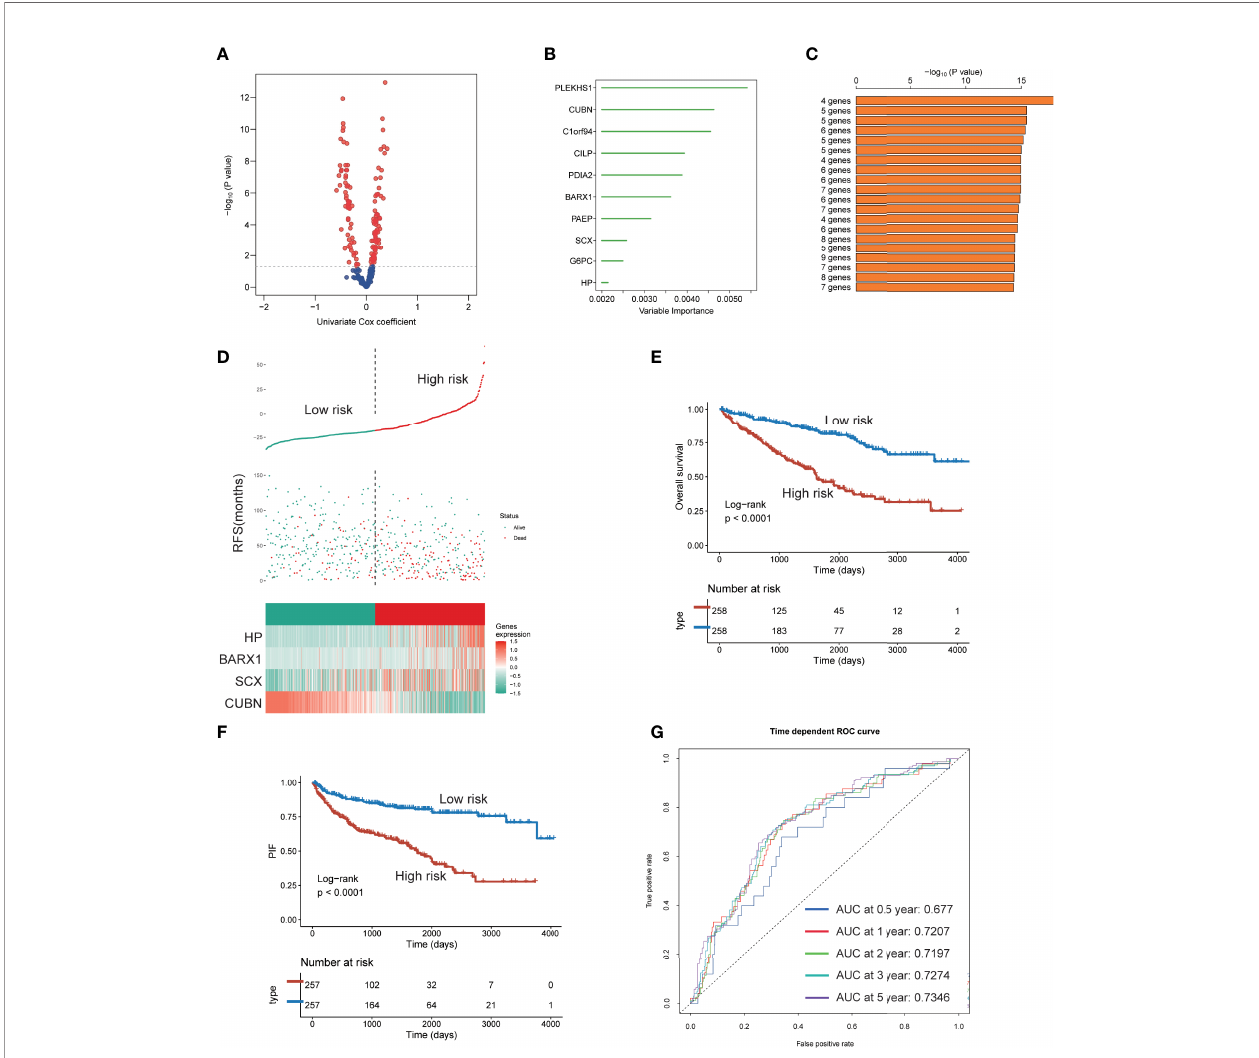
FIGURE 10 | Establishment of a four IGF genes risk model. (A) Volcano plot indicating the signi fi cantly altered biomarkers among the three subtypes by univariable Cox regression analysis. (B) Random survival forest analysis screening 10 genes. (C) Based on various combination analyses, the top 20 signatures are listed according to p-values. (D) Risk score analysis in TCGA-ccRCC cohort. (E-F) Survival analysis for OS (E) and PFS (F) of the two risk groups in TCGA-ccRCC cohort. (G) The time-dependent ROC curves for the two risk groups in TCGA-ccRCC